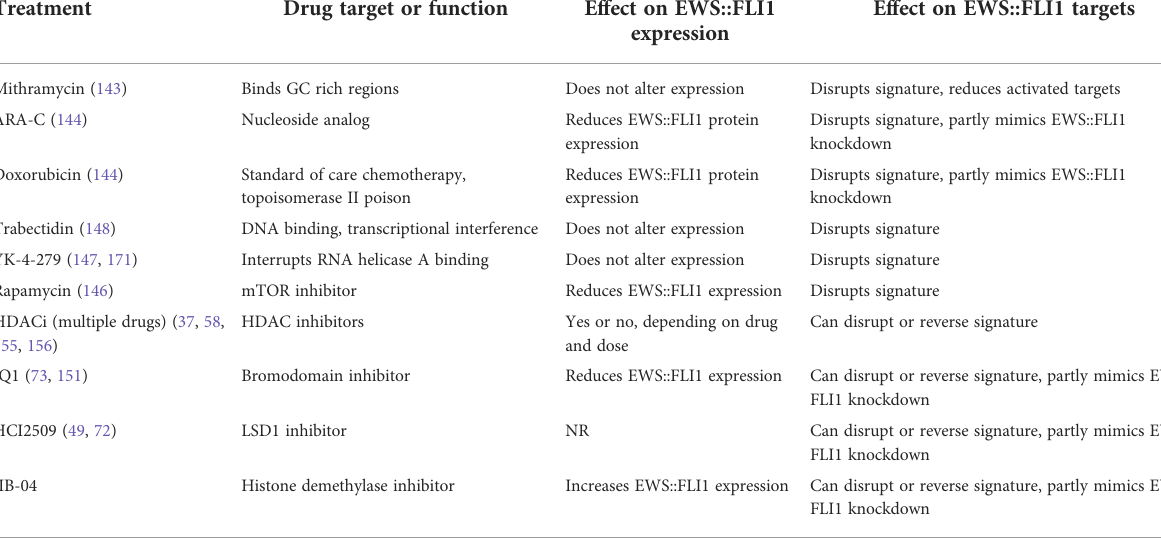
TABLE 2 Summary of selected drugs and small molecules and their effects on EWS::FLI1 and its gene signatures.